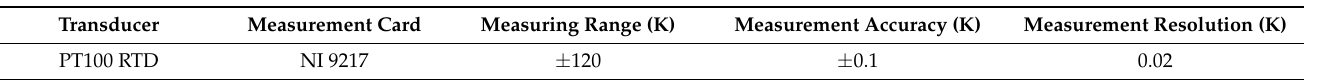
Table 3. Technical specification of the PT100 RTD temperature sensor.